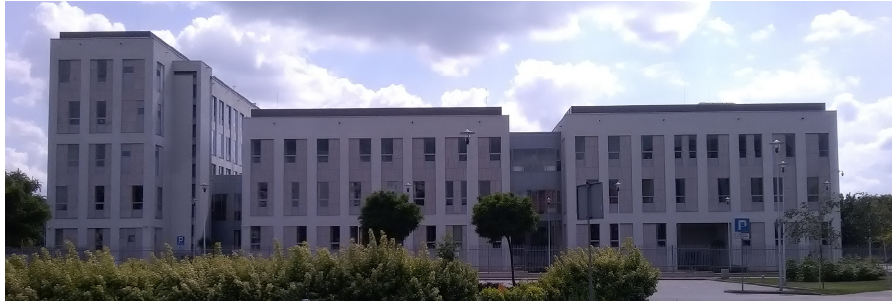
Figure 2. Courthouse in Radom (Northern façade).